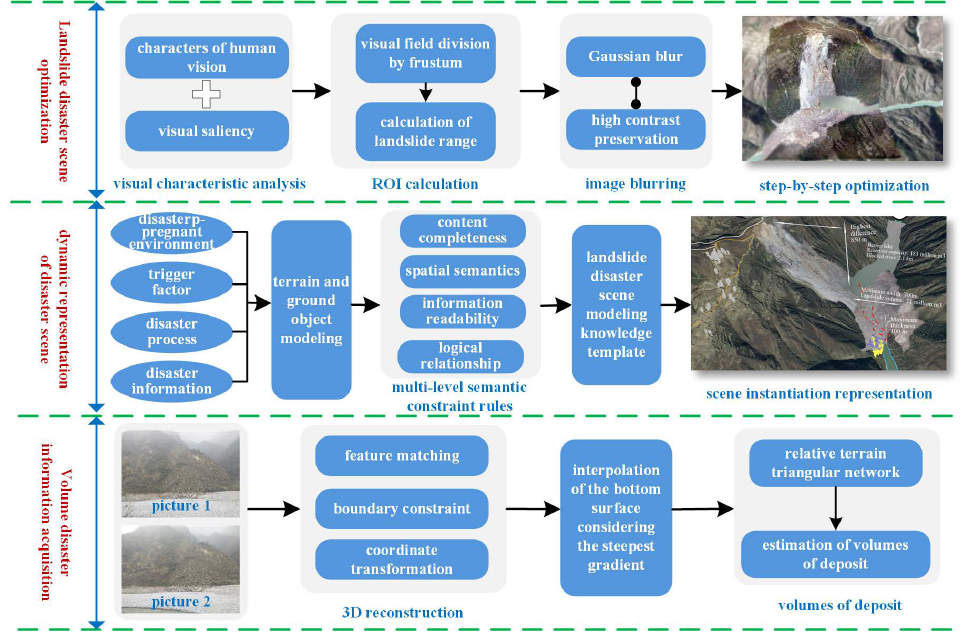
Figure 1. Overall